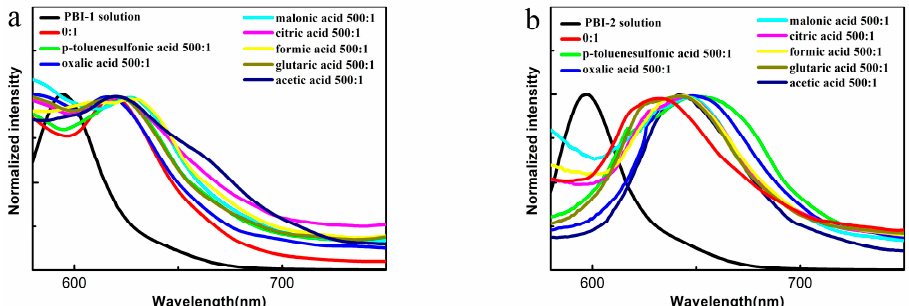
Figure3. NormalizedfluorescenceemissionspectrumofPBI-RsolutionandPBI-Raggregatesassembled Figure 3. Normalized fluorescence emission spectrum of PBI-R solution and PBI-R aggregates in various organic acids. ( a ) PBI-1 and ( b ) assembled in various organic acids. ( a ) PBI-1 and ( b ) PBI-2. Figure 3. Normalized fluorescence emission spectrum of PBI-R solution and PBI-R aggregates assembled in various organic acids. ( a ) PBI-1 and ( b ) PBI-2. Figure 3. Normalized fluorescence emission spectrum of PBI-R solution and PBI-R aggregates assembled in various organic acids. ( a ) PBI-1 and ( b ) PBI-2.